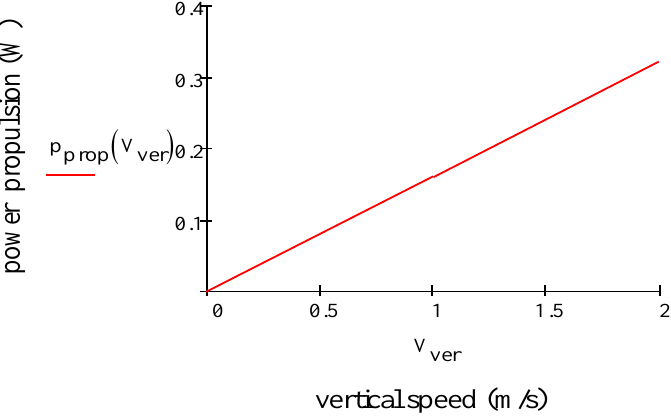
Figure 3. Electric power consumption for the propulsion of one motor vs. vertical speed.